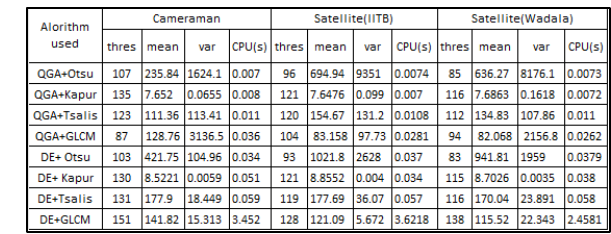
Table 3 : Comparison of Threshold, Mean, Variance, and CPU Time (in sec) for different